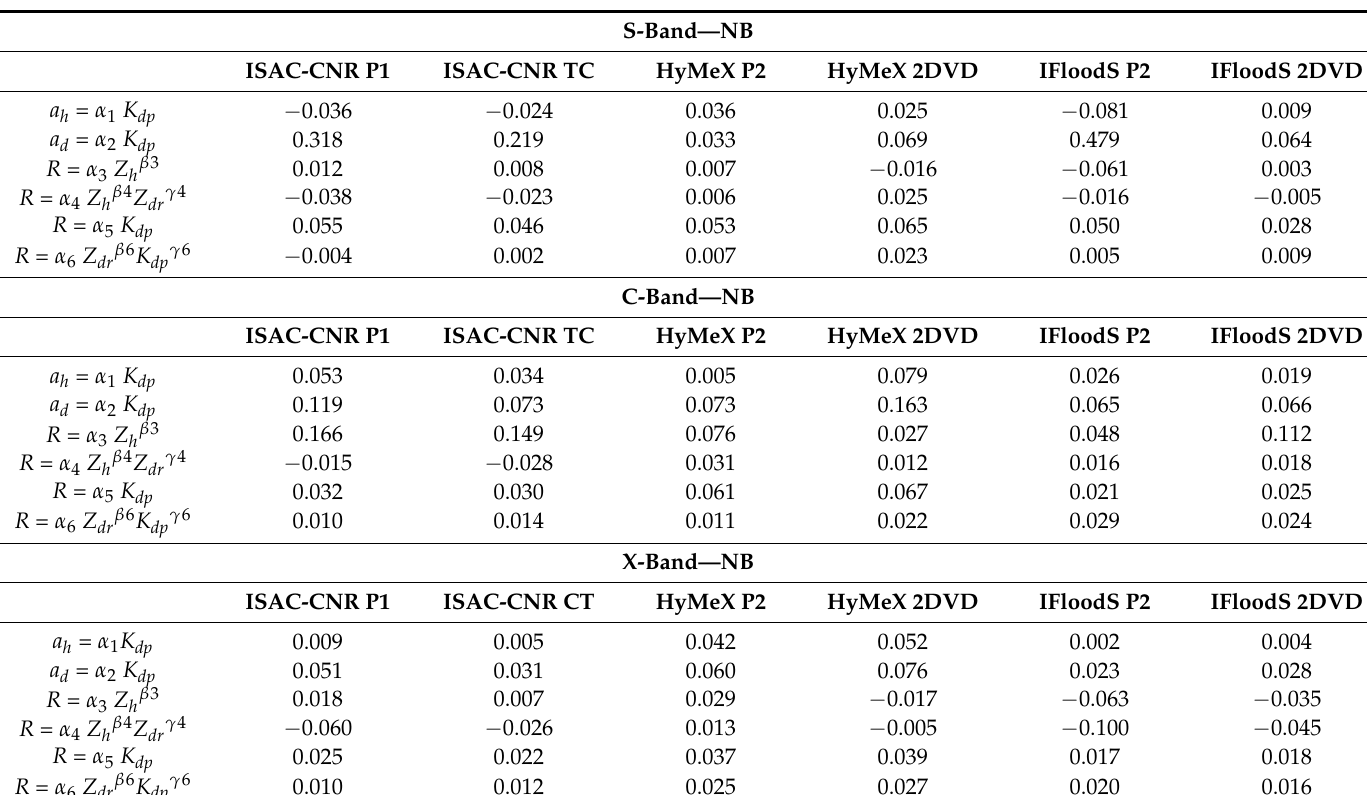
Table 3. As for Table 2, but for the absolute value of